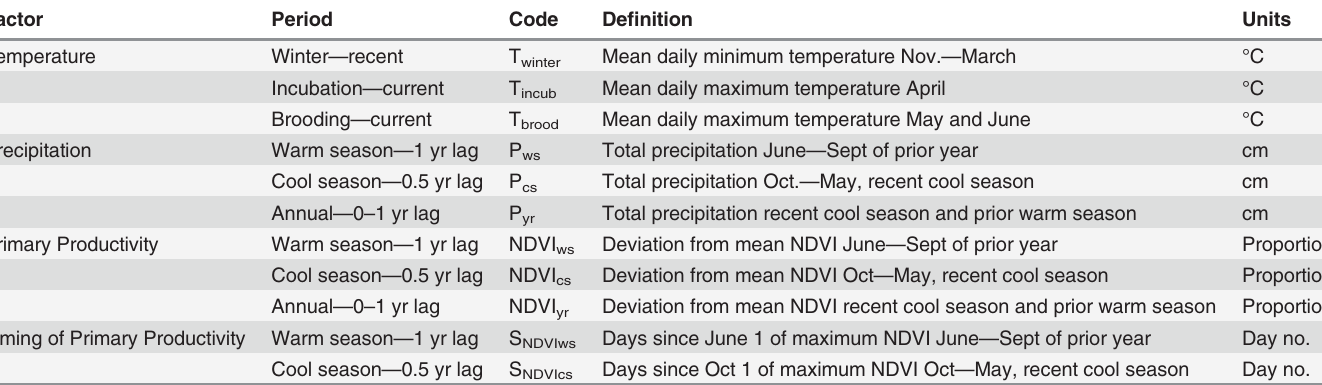
Table 2. Factors considered when modeling the effects of weather and primary productivity on reproductive output of ferruginous pygmy-owls in northwest Mexico, 2001 – 2010.